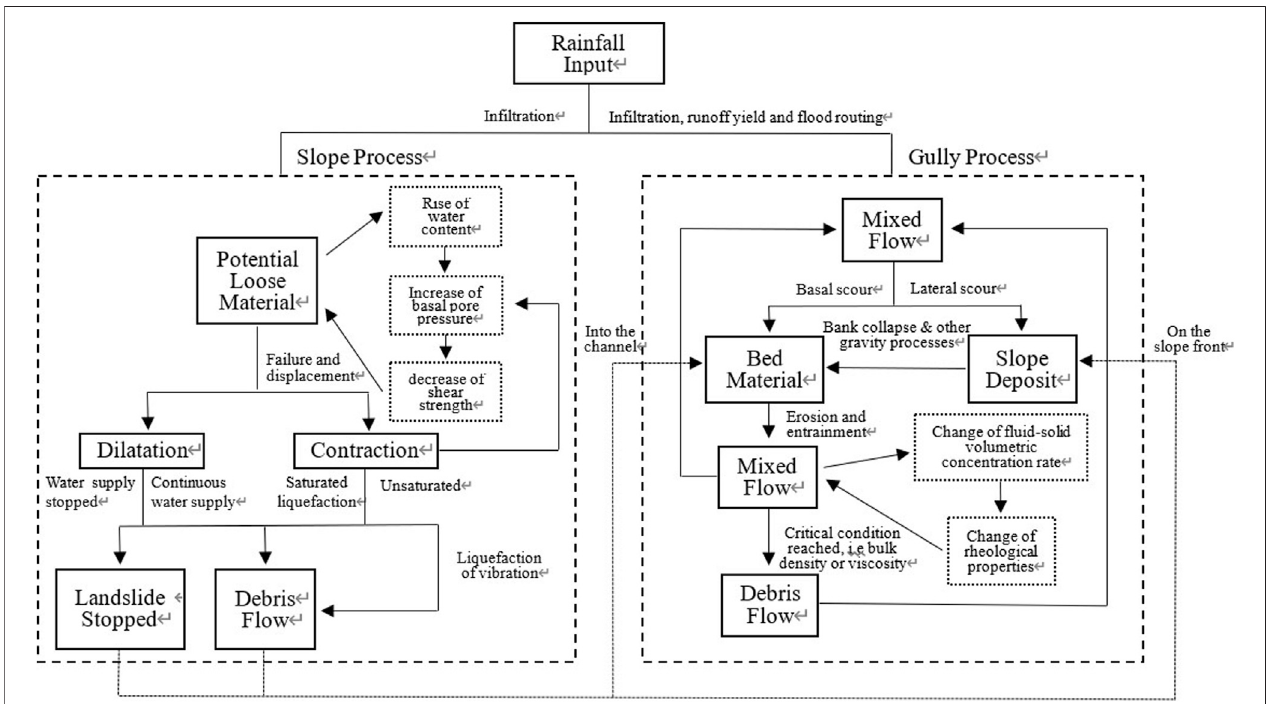
FIGURE 1 | Difference and connection between the general initial types of debris fl ow from slope and